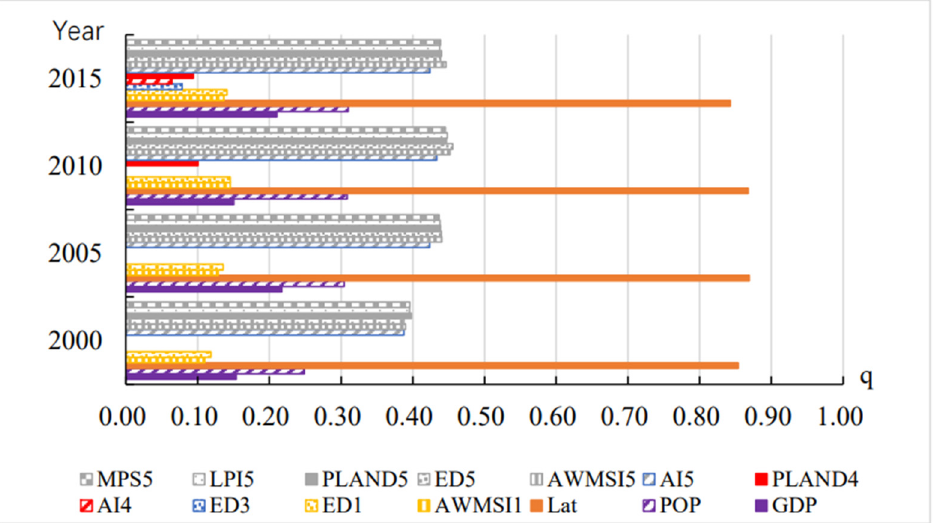
Figure 12. Q statistics between annual frequency of extreme cold comfort and driving factors (1: cultivated land; 2: green space; 3: water bodies; 4: construction land; 5: unused land).